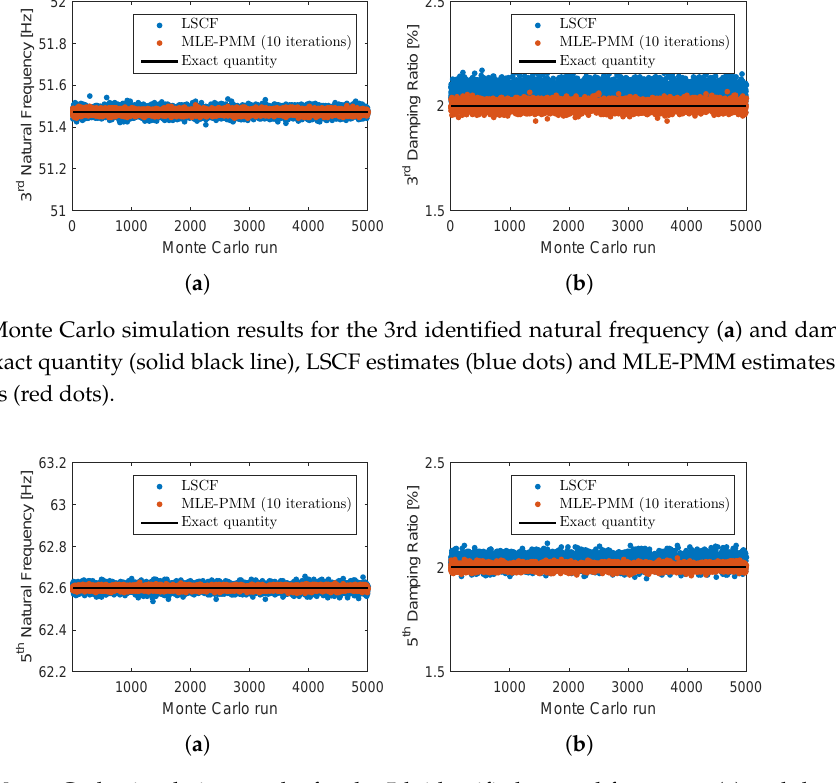
Figure 5. Monte Carlo simulation results for the 5th identified natural frequency ( a ) and damping ratio ( b ): exact quantity (solid black line), LSCF estimates (blue dots) and MLE-PMM estimates after 10 iterations (red